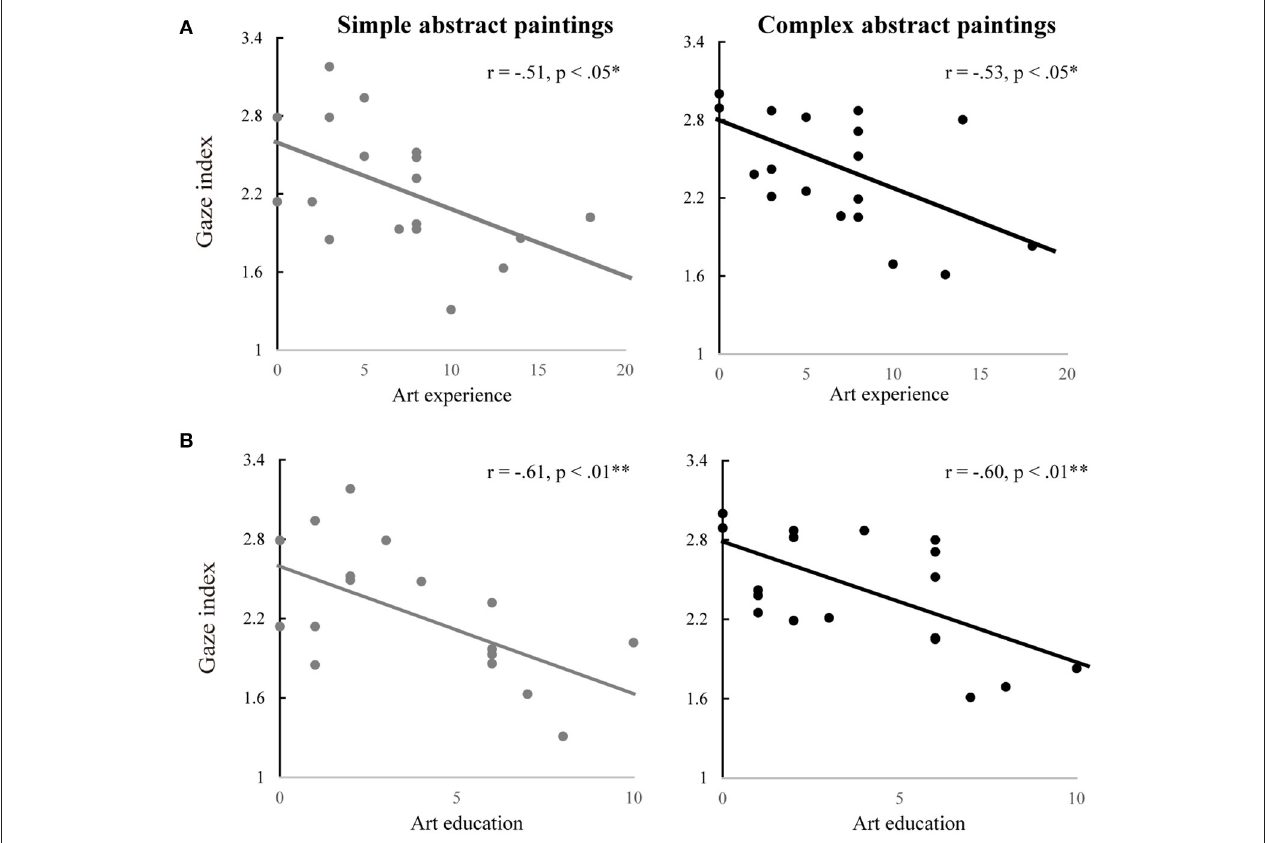
FIGURE 6 | The ratio of fixation count and art experience in simple and complex abstract paintings. (A) Correlations between the gaze indices and art experience scores for the simple (left) and complex abstract paintings (right). (B) Correlations between the gaze index and art education for simple (left) and complex abstract paintings (right). * p < 0.05,** p <